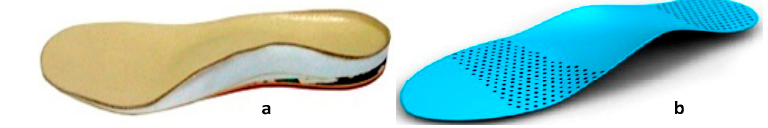
Figure 3. Both supply chain networks for orthopedic insole.